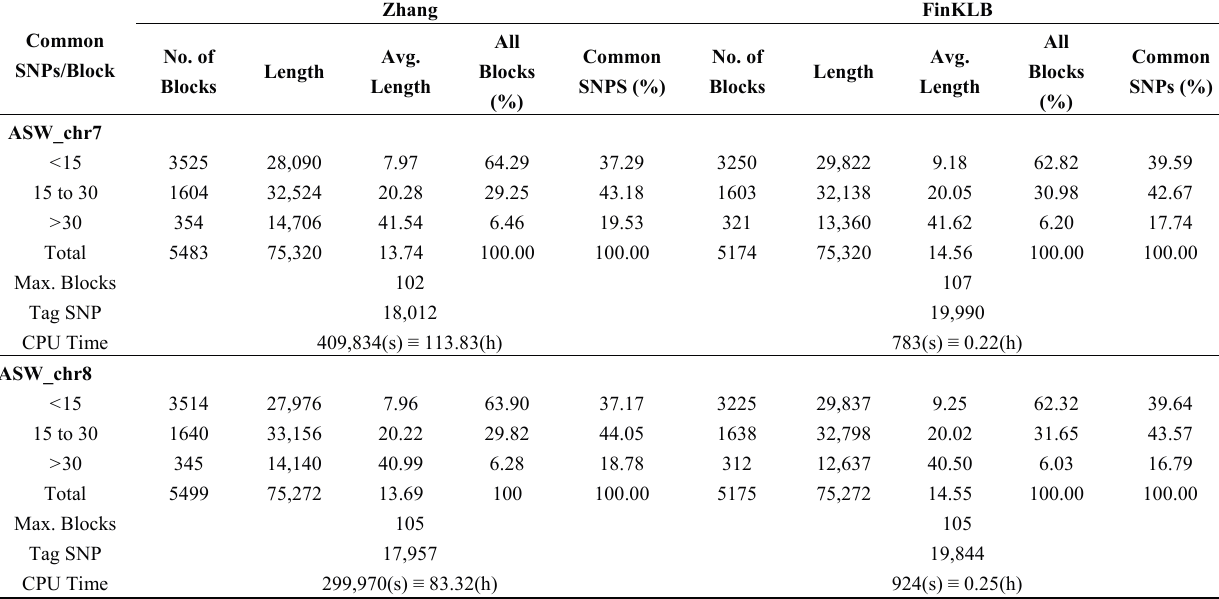
Table 1. The properties of haplotype blocks obtained by Zhang et al. ’s algorithm [20] and our FinKLB algorithm. The datasets contain chromosomes 7, 8, 9, and 10 from an ASW population. The criterion was 80% coverage of the common